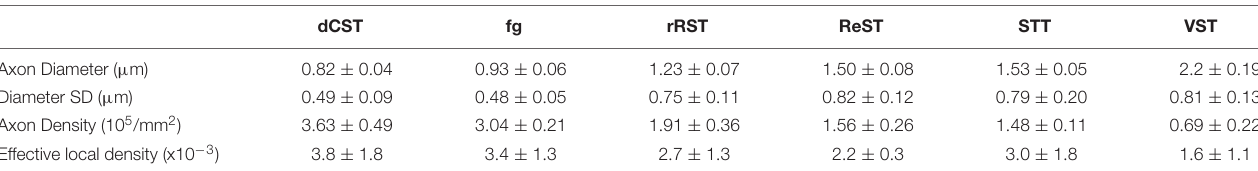
TABLE 2 | Average regional histologic characteristics of WM